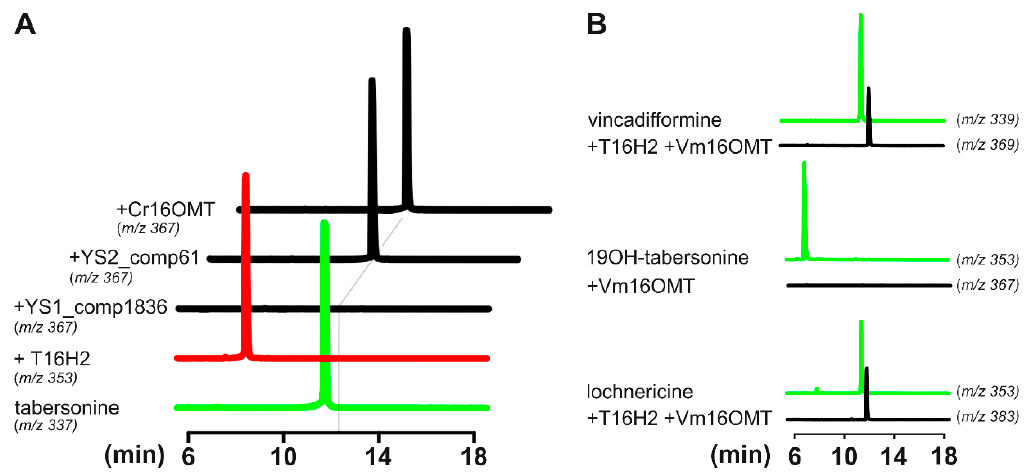
Figure 7. Screening selected candidates for tabersonine 16- O -methyltransferase activity. ( A ) Galactose induced yeast cell cultures co-expressing T16H2 (red line) with selected 16OMT-like candidates (YS1_comp1836_seq0 and YS2_comp61_seq0) and positive control Cr16OMT (black lines), incubated with tabersonine (green line, m / z 337). Selected ion monitoring and comparisons to authentic standards were used to detect the resulting hydroxylated ( m / z 353) and methylated ( m / z 367) tabersonine products by LC–MS analysis. The grey line highlights 16-methoxytabersonine retention time. ( B ) Substrate specificity of recombinant Vm16OMT in combination with recombinant T16H2 was determined by coincubation with 19OH-tabersonine, lochnericine and vincadi ff ormine (green lines), forming methylated products that were detected by UPLC–MS (black lines). No methylated product was observed after incubation of recombinant Vm16OMT with